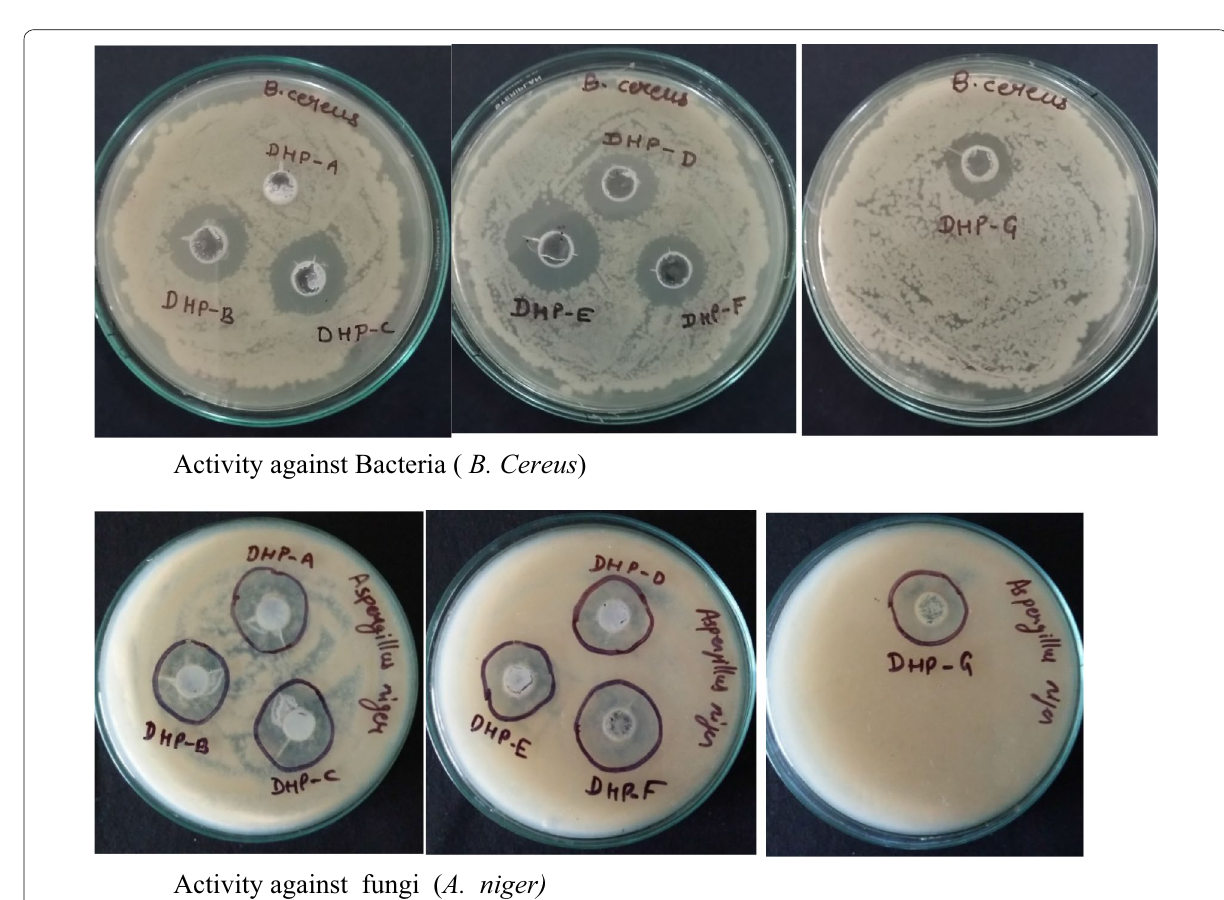
Fig. 6 Bilogical assay for antibacterial activity. Activity against bacteria ( B. cereus ), activity against fungi ( A. niger )